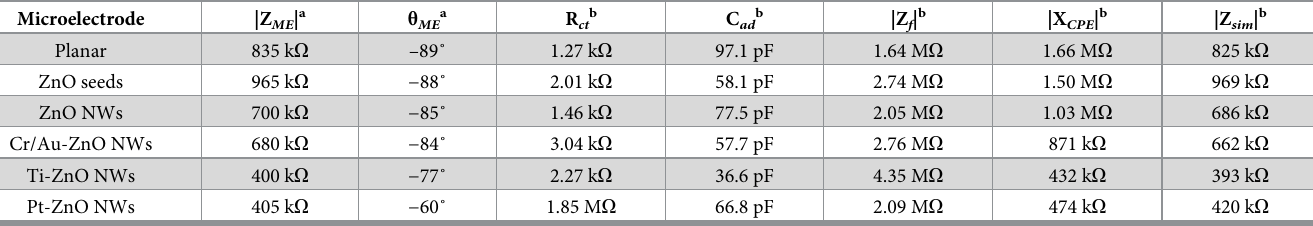
Table 1. Impedance parameters of the microelectrodes. Parameters are measured by fitting the measured impedance (after the open/short circuit compensation) to the modified Randles equivalent circuit.